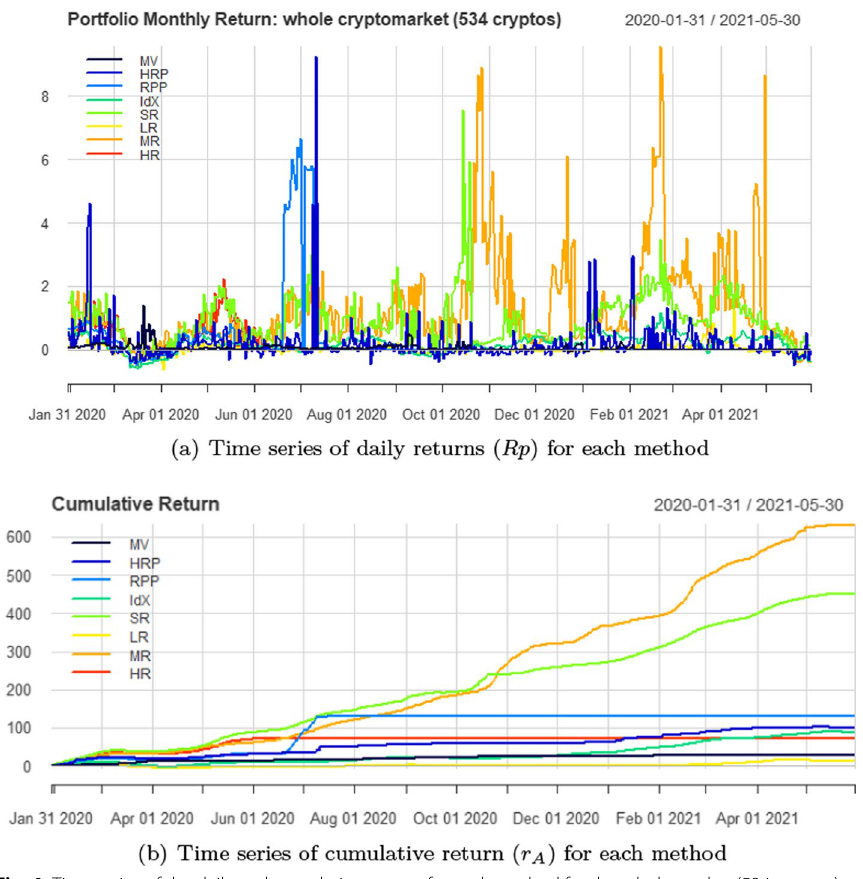
Fig. 4 Time series of the daily and cumulative returns for each method for the whole market (534 cryptos)